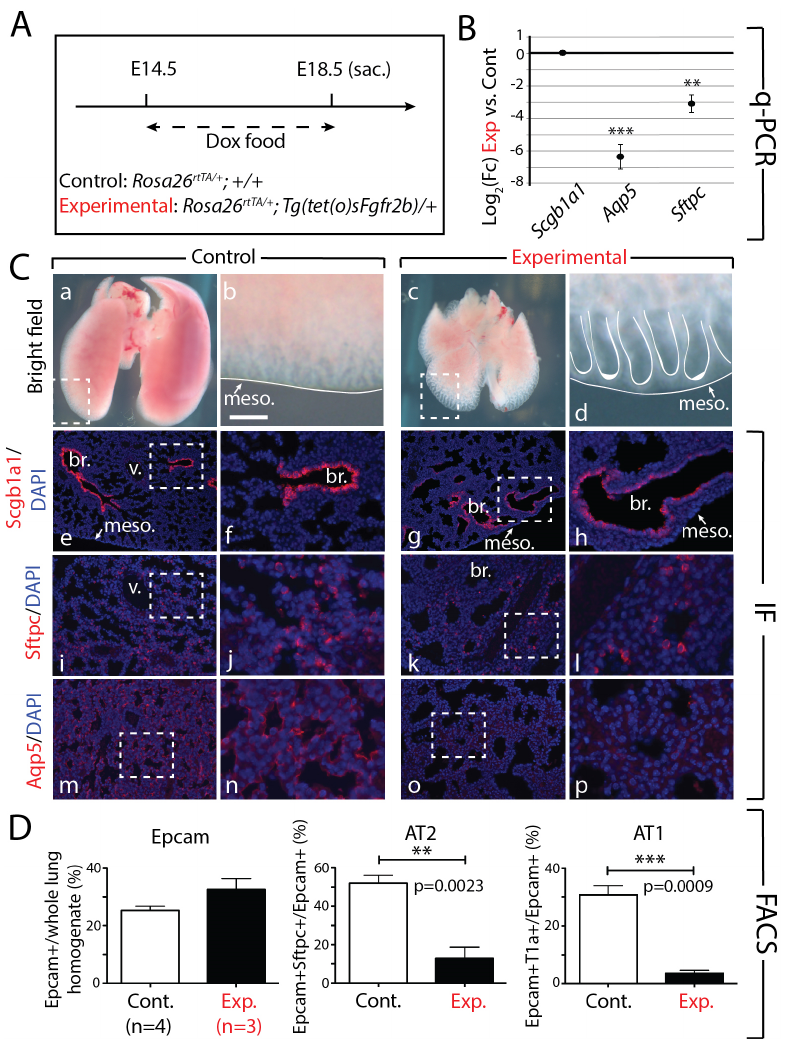
Figure 5. Continuous inhibition of Fgfr2b signaling from E14.5 to E18.5 leads to impaired AT1 and AT2 formation. (A) Experimental design: pregnant females carrying experimental and littermate control embryos were fed Dox food continuously for four days before being sacrificed at E18.5. (B) qPCR analysis showing significant downregulation of the AT1 marker Aqp5 and the AT2 marker Sftpc in experimental versus control lungs. Scgb1a1 shows no change in expression. ( n = 3; ** p -value < 0.01, *** p -value < 0.001). (C) Brightfield (a–d) and immunofluorescent (e–p) images of control and experimental lungs. Note the smaller overall size and the dilated epithelial branches of experimental lungs compared to controls (c and d vs. a and b). Staining for Scgb1a1 shows a clear boundary between Scgb1a1+ proximal and Scgb1a1-negative distal epithelium in control lungs (e and f), whereas an ectopic distribution is seen in experimental lungs (g and h), with Scgb1a1+ cells being found in distal regions of the lung. Staining for Sftpc (i-l) and Aqp5 (m-p) reveal a downregulation of these proteins in experimental compared to control lungs, confirming the downregulation of these genes seen in the qPCR analysis (B). (meso. = mesothelium, br. = bronchus, v. = vessel). Scale bar: (a, c) 750 µm, (b, d) 95 µm, (e, g, i, k, m, o) 150 µm, (f, h, j, l, n, p) 30 µm. (D) FACS-based quantification shows no significant difference in the proportion of Epcam+ (epithelial) cells relative to the total (CD45- CD31-) lung cells in experimental versus control lungs, but a significant decrease in the proportion of AT2 (Epcam + Sftpc + from total Epcam + ) (** p -value < 0.01) and AT1 (Epcam + T1alpha + from total Epcam + ) (*** p -value < 0.001) cells in experimental versus control